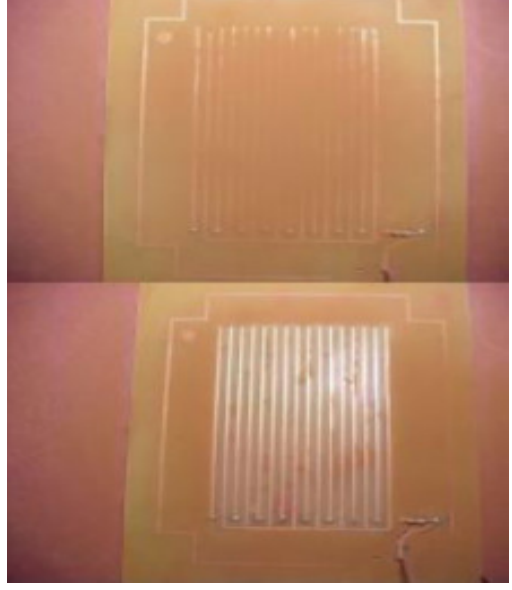
Figure 34. EDS before ( up ) and after ( down ) voltage is applied [140].